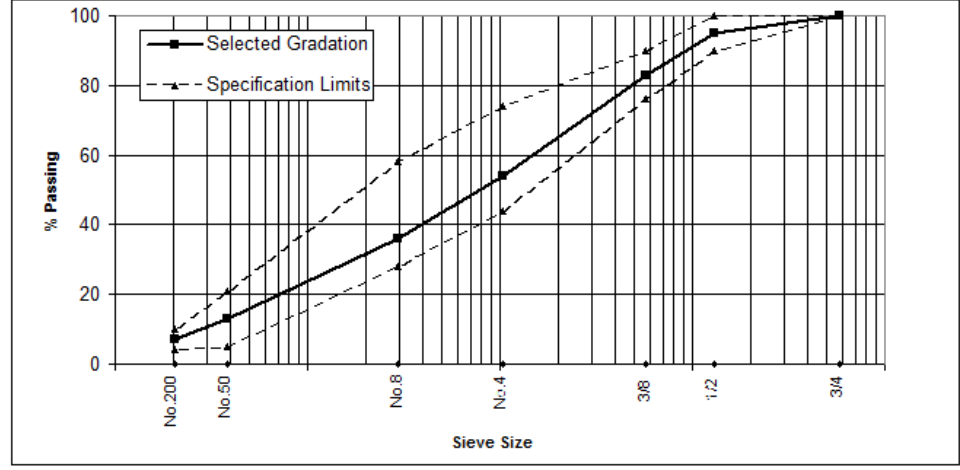
Figure 1. Aggregate gradation.